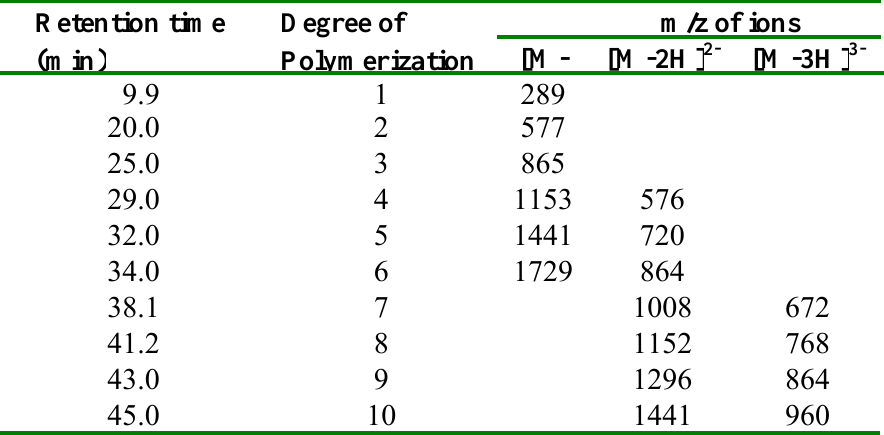
Table 1. HPLC-UV-MS/MS spectral information of flavan-3-ol compounds identified in grape seeds.